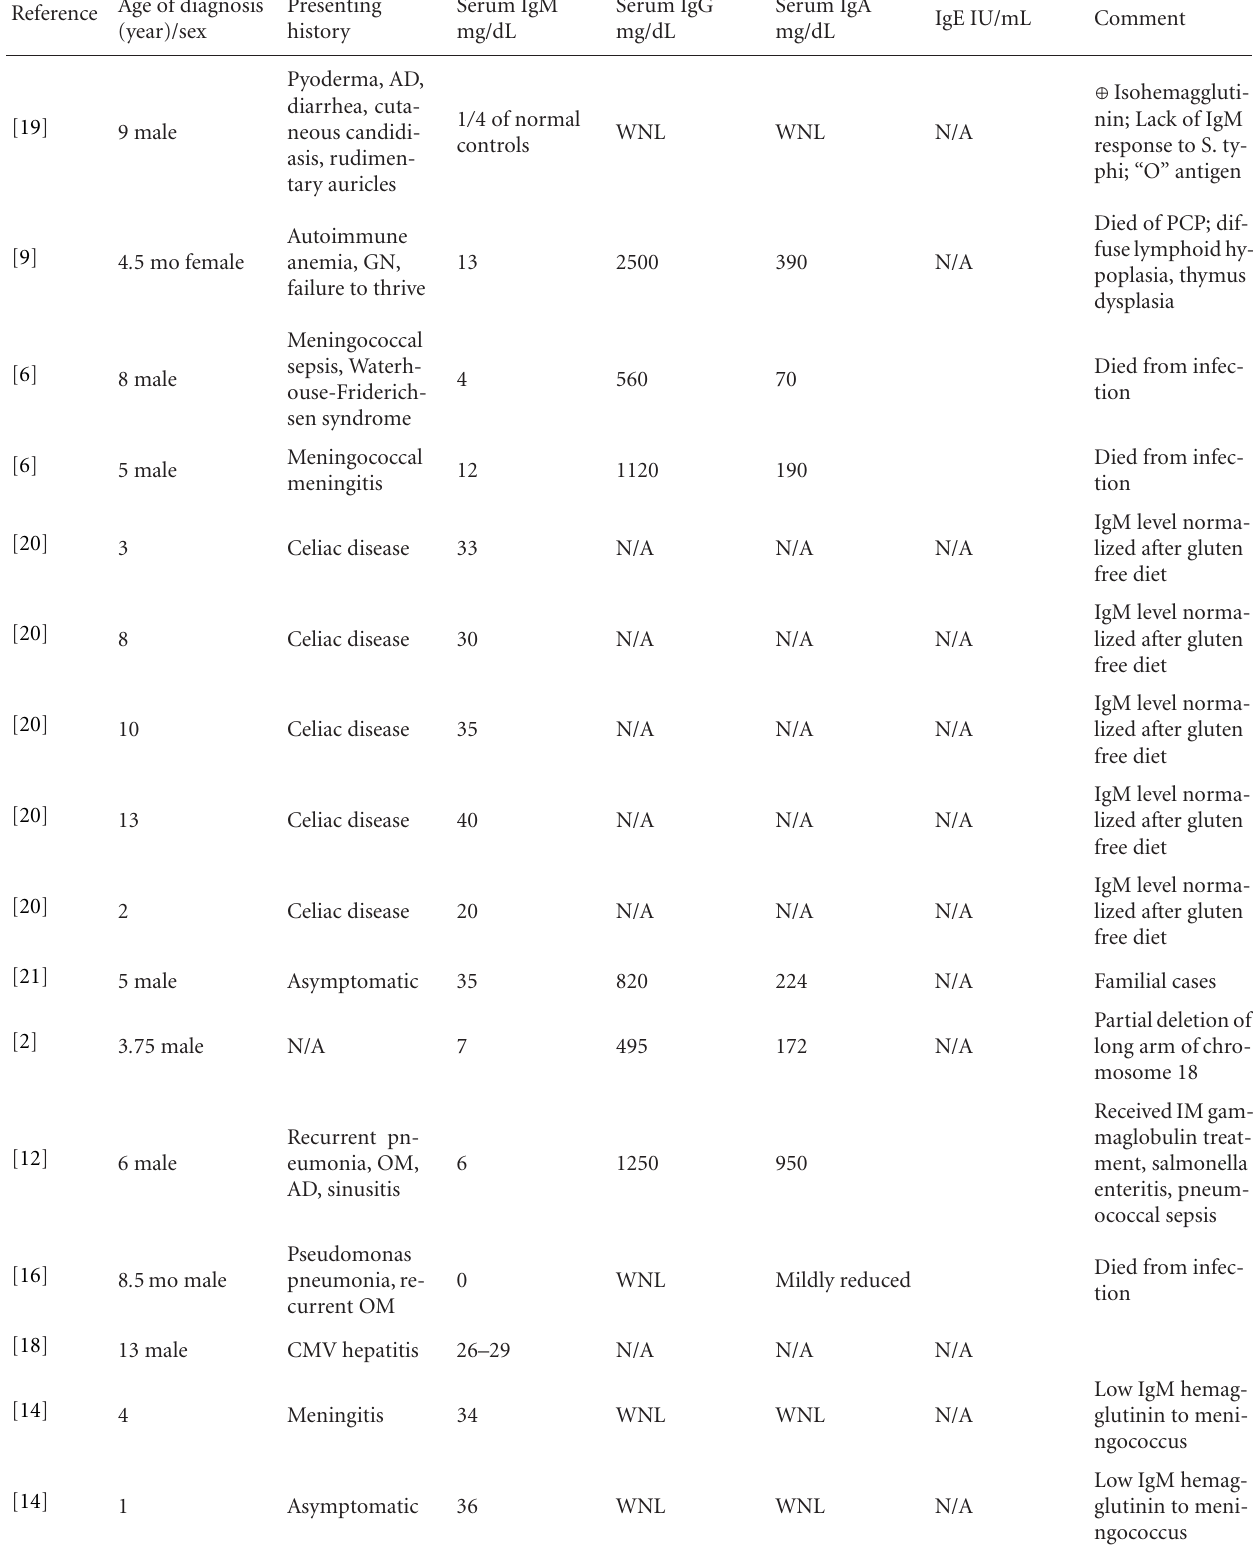
Table 1: Characteristics of previously reported pediatric cases of SIgMID. WNL: within normal limits, GN: glomerulonephritis, CMV: cytomegalovirus, AD: atopic dermatitis, N/A: not available, OM: otitis media, URI: upper respiratory infection. Reference Age of diagnosis